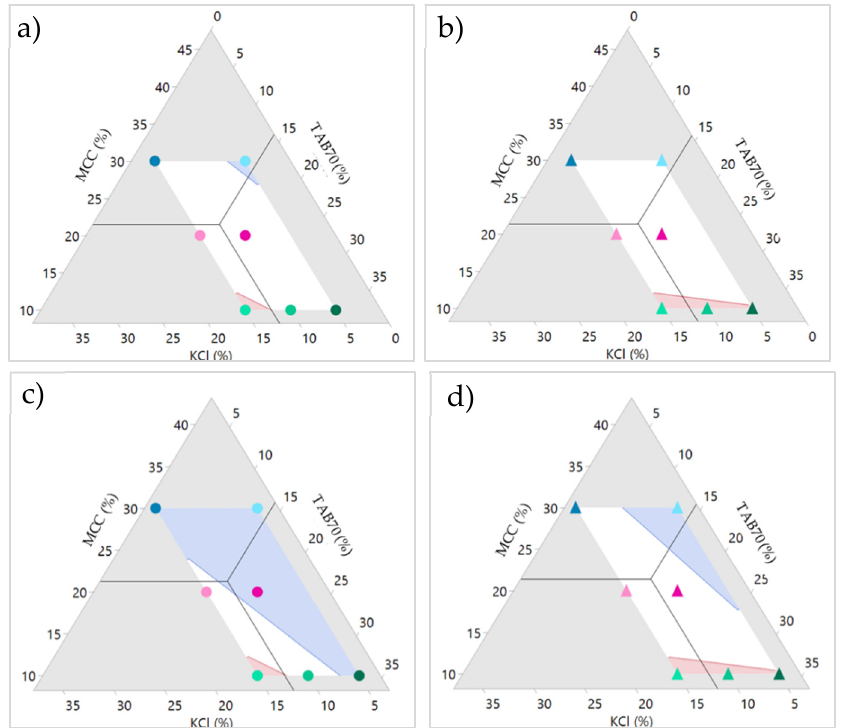
Figure 14. Design spaces generated for round (dots; a and c ) and oblong (triangle; b and d ) ITZASD tablets with tensile strength target more than 1.7 MPa and disintegration target of 15 min for ( a ) and ( b ) and 5 min for ( c ) and ( d ); marker at verification formulation with 11.9% KCl, 21.43% MCC and 14.26% TAB70.